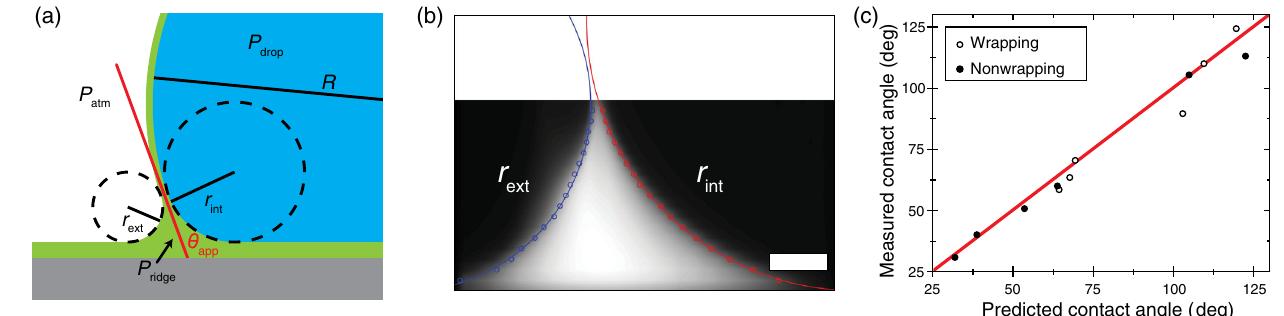
> 0 ). (b) Confocal image confirming LD